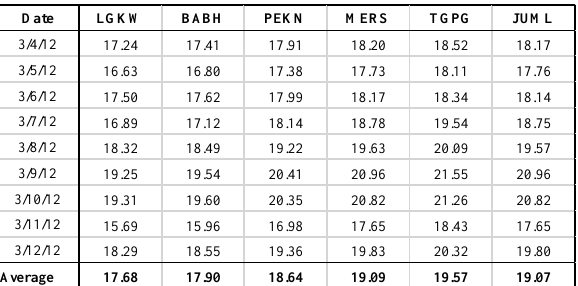
Table 4. Ionospheric delay for all MyRTKnet stations at frequency, L2= 1227.60 MHz.